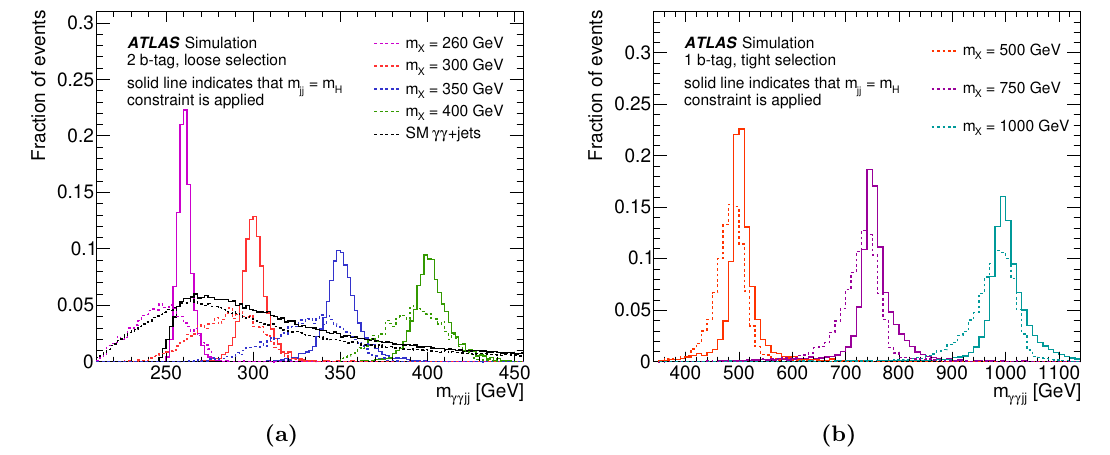
Figure 2. Reconstructed m (cid:13)(cid:13)jj with (solid lines) and without (dashed lines) the dijet mass constraint, for a subset of the mass points used in the resonant analysis. The examples shown here are for (a) the 2-tag category with the loose selection and (b) the 1-tag category with the tight selection. The e(cid:11)ect on the continuum background is also shown in